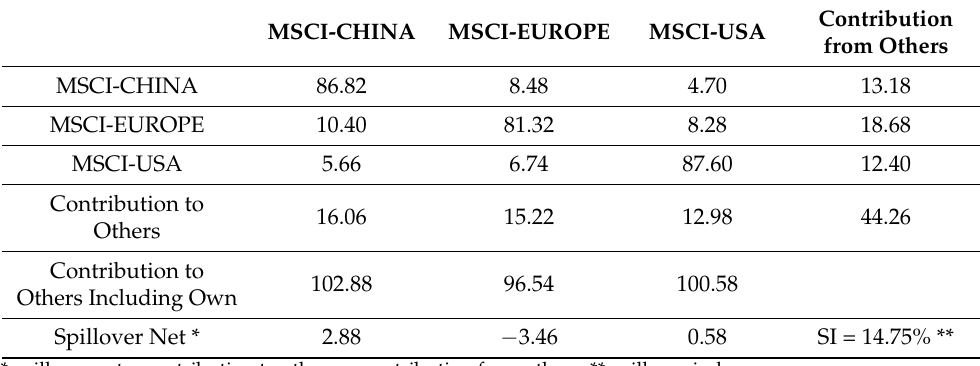
Table 4. Volatility spillover index (pre-crisis period).